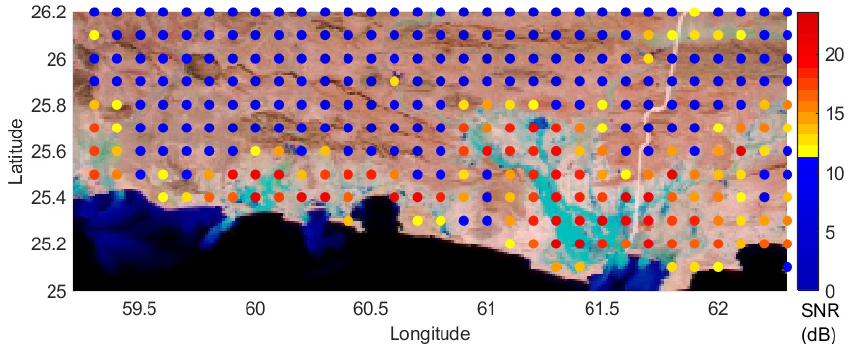
Figure 12. The georeferenced optical satellite imagery of the flood over coastlines and inundation of the nearby rivers (region B in Figure 10) from MODIS (13 January 2020) overlaid by the corrected SNR derived from CYGNSS observations (13 January to 15 January 2020).